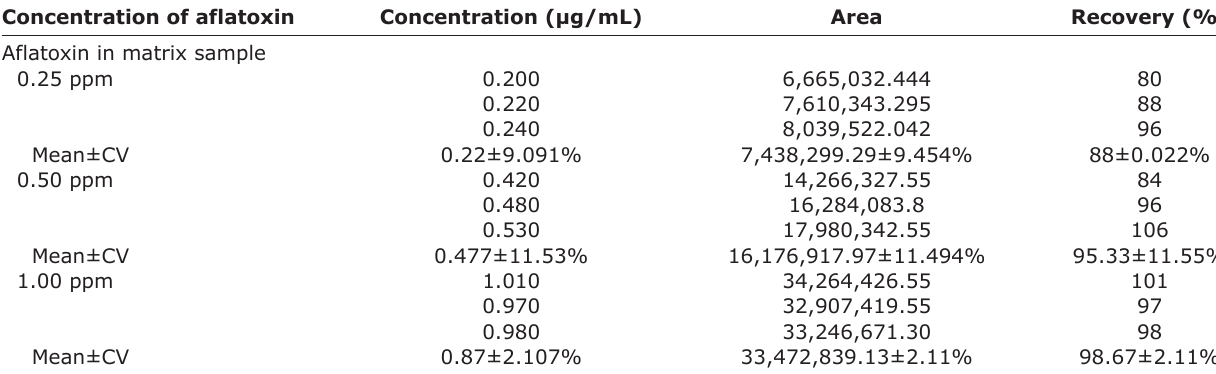
in matrix samples. 1